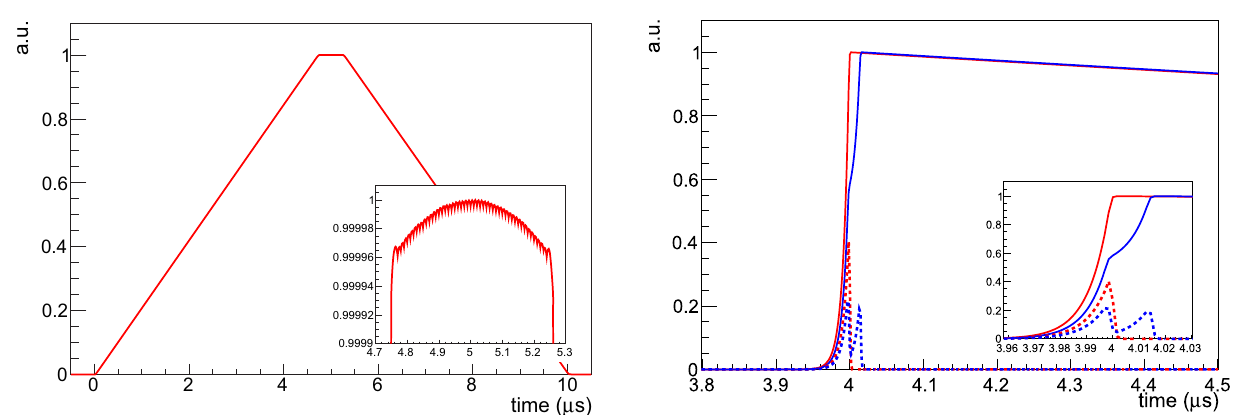
Fig. 5 The two simulated BEGe detector SSE (red) and MSE (blue) noiseless signals at the preamplifier output and their associated current pulses (dashed lines)